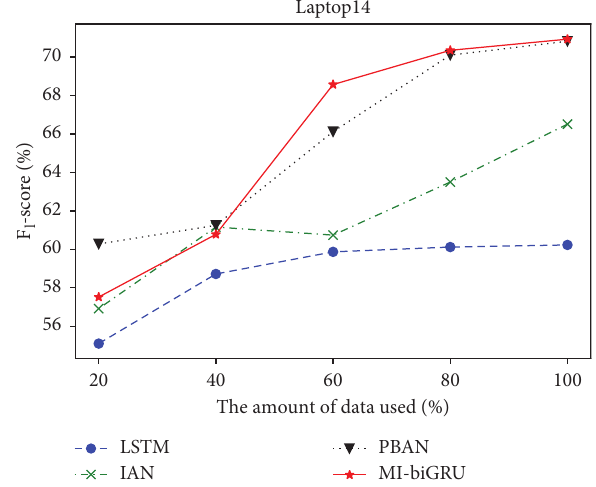
Figure 6: F1-score trend of baseline models in laptop